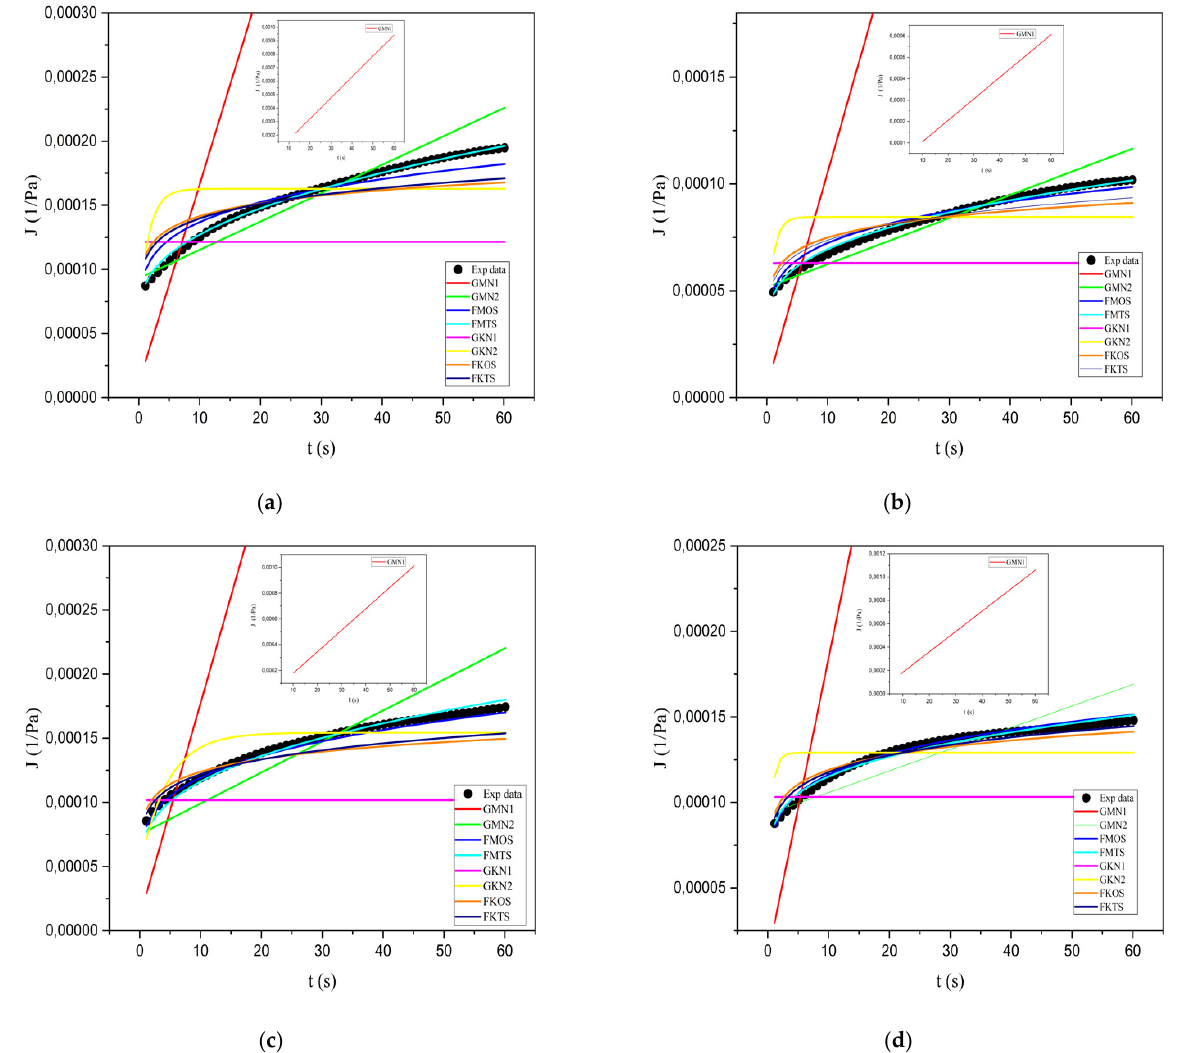
Figure 7. The experimental values of creep compliance and generalized Maxwell and Kelvin models (N = 1 and N= 2), fractional Maxwell models with one and two spring-pots, and fractional Kelvin models with one and two spring-pots: ( a ) F1; ( b ) F2; ( c ) F3; ( d ) F4. (GMN1: Generalized Maxwell model (N = 1); GMN2: Generalized Maxwell model (N = 2); FMOS: Fractional Maxwell Model with One Spring-pot; FMTS: Fractional Maxwell Model with Two Spring-pots; GKN1: Generalized Kelvin model (N = 1); GKN2: Generalized Kelvin model (N = 2); FKOS: Fractional Kelvin Model with One Spring-pot; FKTS: Fractional Kelvin Model with Two Spring-pots).